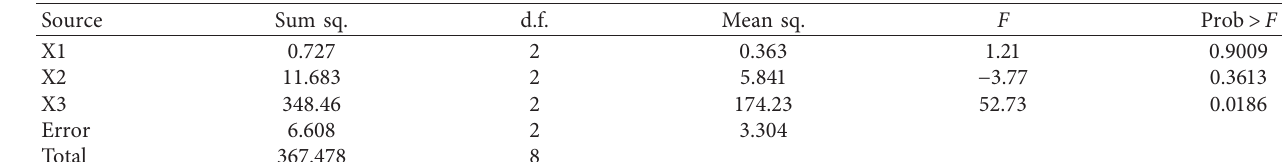
Table 4: The values of the influence factor F.